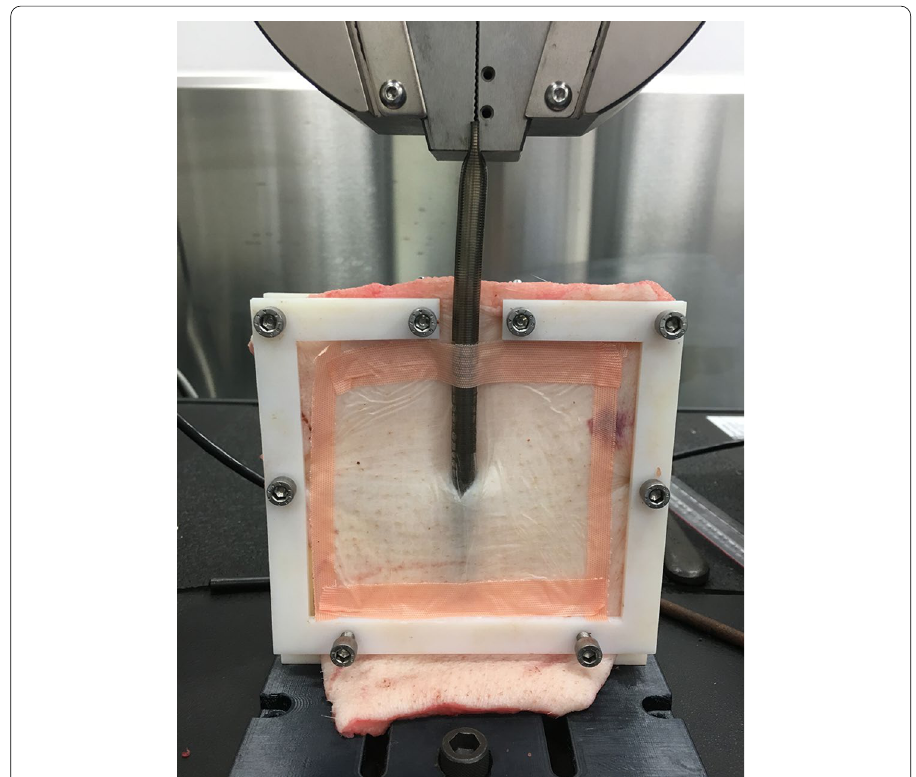
Fig. 1 Secured cannula on the Instron 5567 Universal Testing